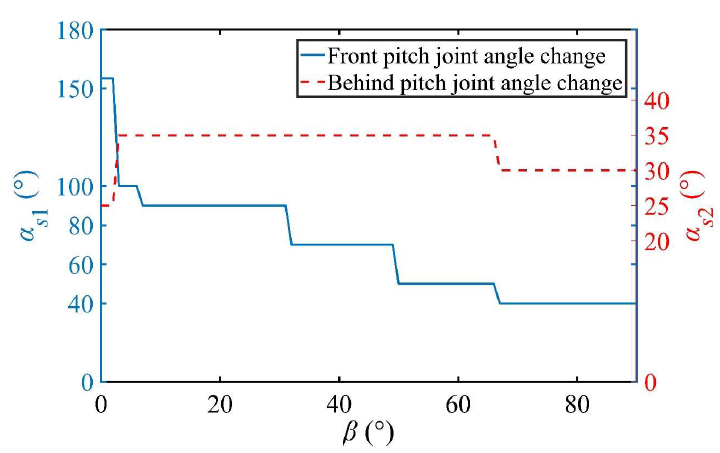
Figure 7. Variation of the pitch angle of the front and behind rotor joints of DP-Climb.